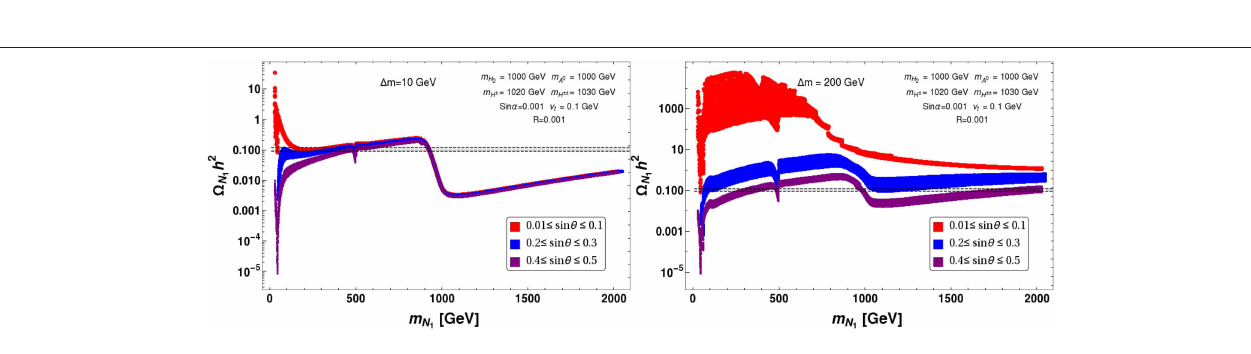
FIGURE 27 | Variation of relic density with DM mass m N keeping fixed region of 1 m : 1 m 1 triplet mass, m H 1000 GeV. Different color patches correspond to different sin θ region : 0.01 2 = (cid:127) h 2 (Purple). Correct relic density, 0.1166 0.1206 is shown by black dashed line. All the masses are in GeVs. ≤ ≤